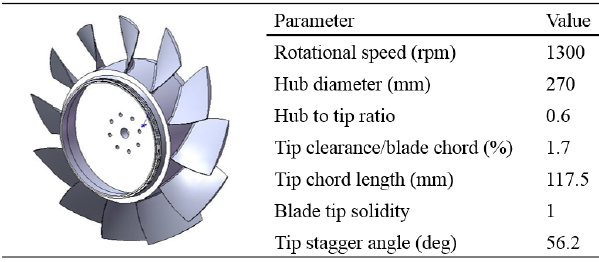
Figure 1. Rotor blade row geometry and